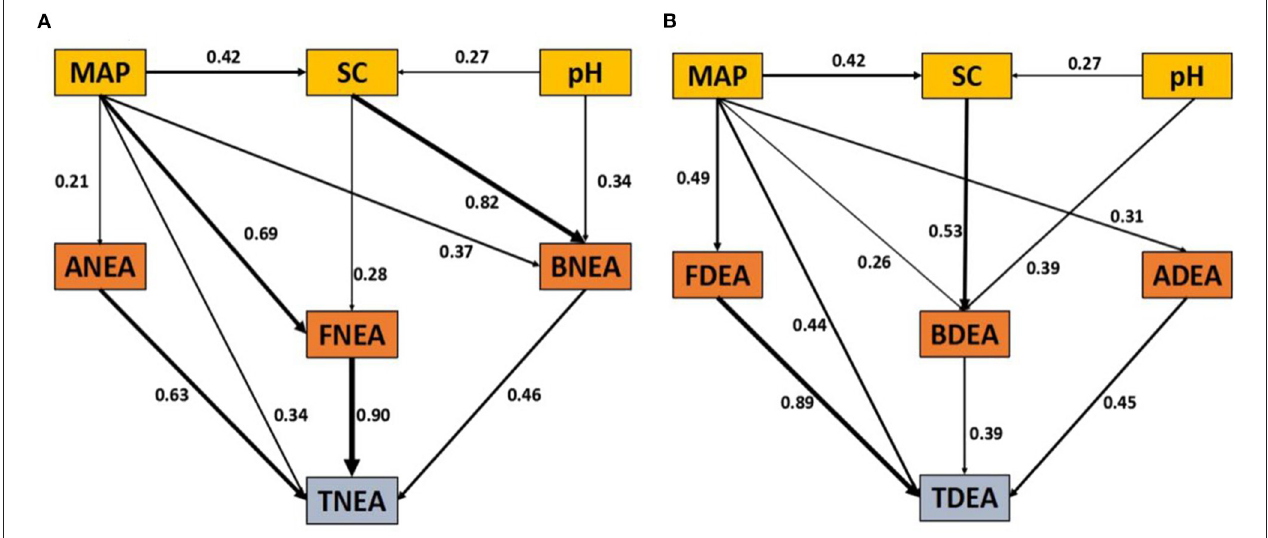
FIGURE 4 | Path plot of the final model, which depicts the pattern observations in both TNEA (A) and TDEA (B) . The coefficients related with arrows represent the coefficients for multiple linear regressions. SC, soil condition; MAP, mean annual precipitation; pH, soil pH. The number of the pathway is the coefficient with significant levels denoted ( p < 0.05).